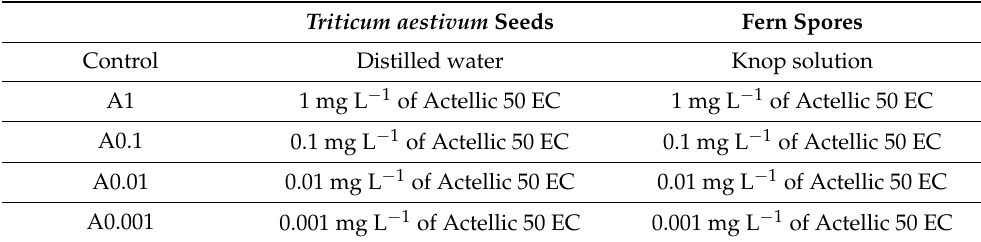
Table 1. The experimental variants. Triticum aestivum Seeds Fern